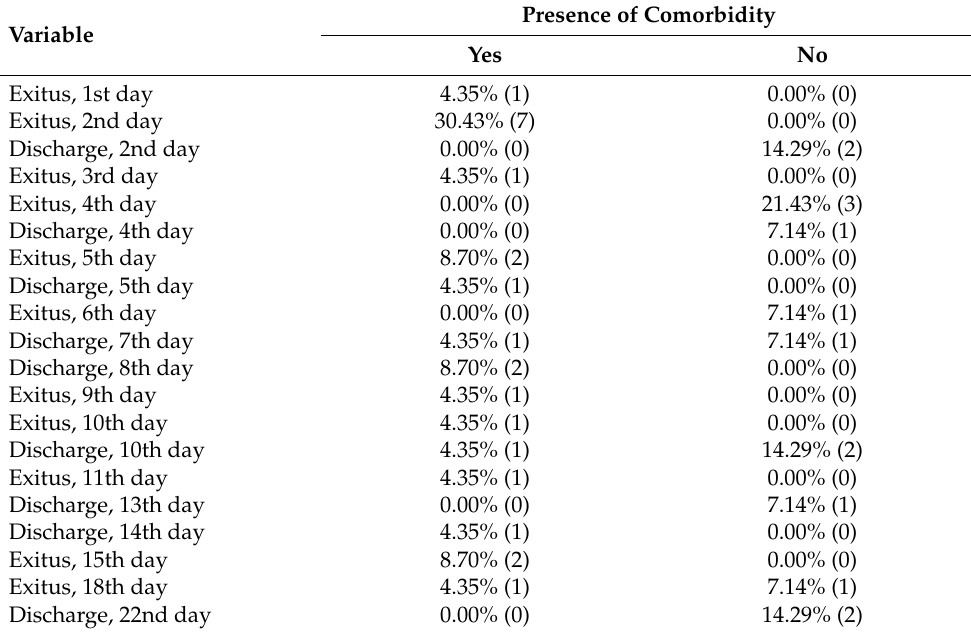
Table 4. Association between presence of comorbidity and exitus/discharge status after PNX.